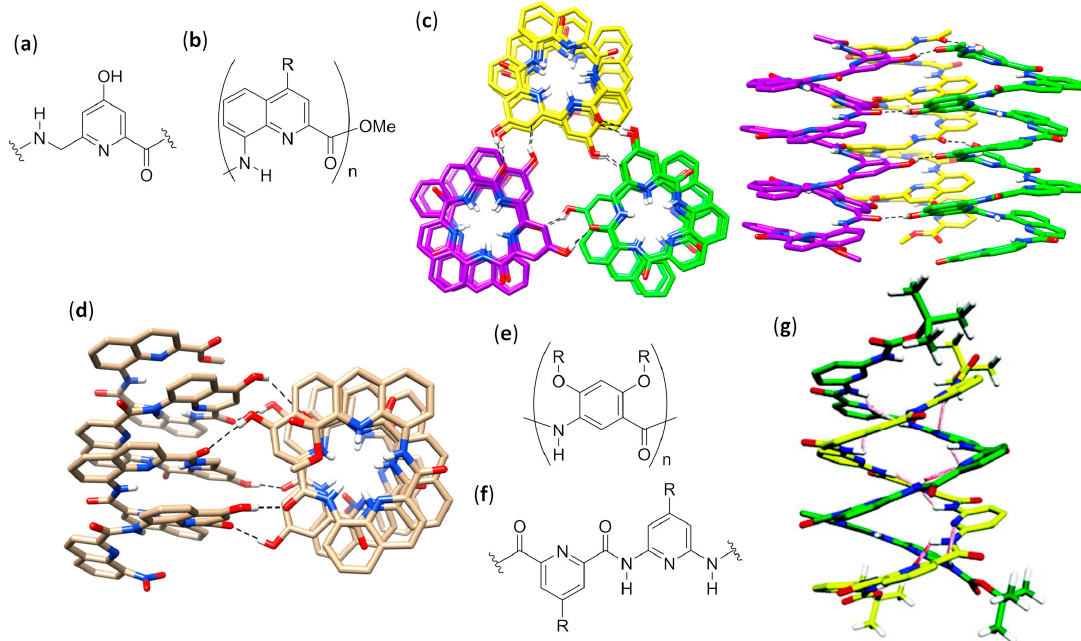
Figure 10. ( a ) Structure of 6-aminomethyl-4-hydroxypicolinic acid (Ref. [140]); ( b ) General structure of 8-amino-2-quinolinecarboxylic acid oligomers (Refs. [140,154]); ( c ) Top (left) and side (right) views of the C 3 -symmetric bundle of Ac-YQXQQYQXQQ-OMe in the crystal (helices reported in different colors, hydrogen bonds reported as dotted lines; alkoxy residues, unnecessary hydrogens, and solvent molecules omitted for clarity); ( d ) View along a helical axis of the tilted dimer of O 2 N-QXQQYQXQQ-OMe in the crystal (hydrogen bonds reported as dotted lines; alkoxy residues and unnecessary hydrogens omitted for clarity); ( e ) General structure of meta -linked benzene oligomers (Refs. [19,141]); ( f ) General structure of pyridinecarboxamides (PDCA) (Refs. [142–149]); ( g ) Calculated structure of 7-PDCA double helix (hydrogen bonds in pink, strands reported in di ff erent colors; side chains and unnecessary hydrogens omitted for clarity) (reprinted with permission from Ref.